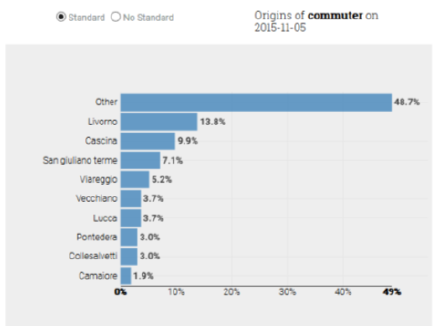
Figure 7. Origin distribution. Distribution of origins for different users categories on the selected day. The horizontal bar chart shows, on the y-axis, provinces/municipalities of residence.